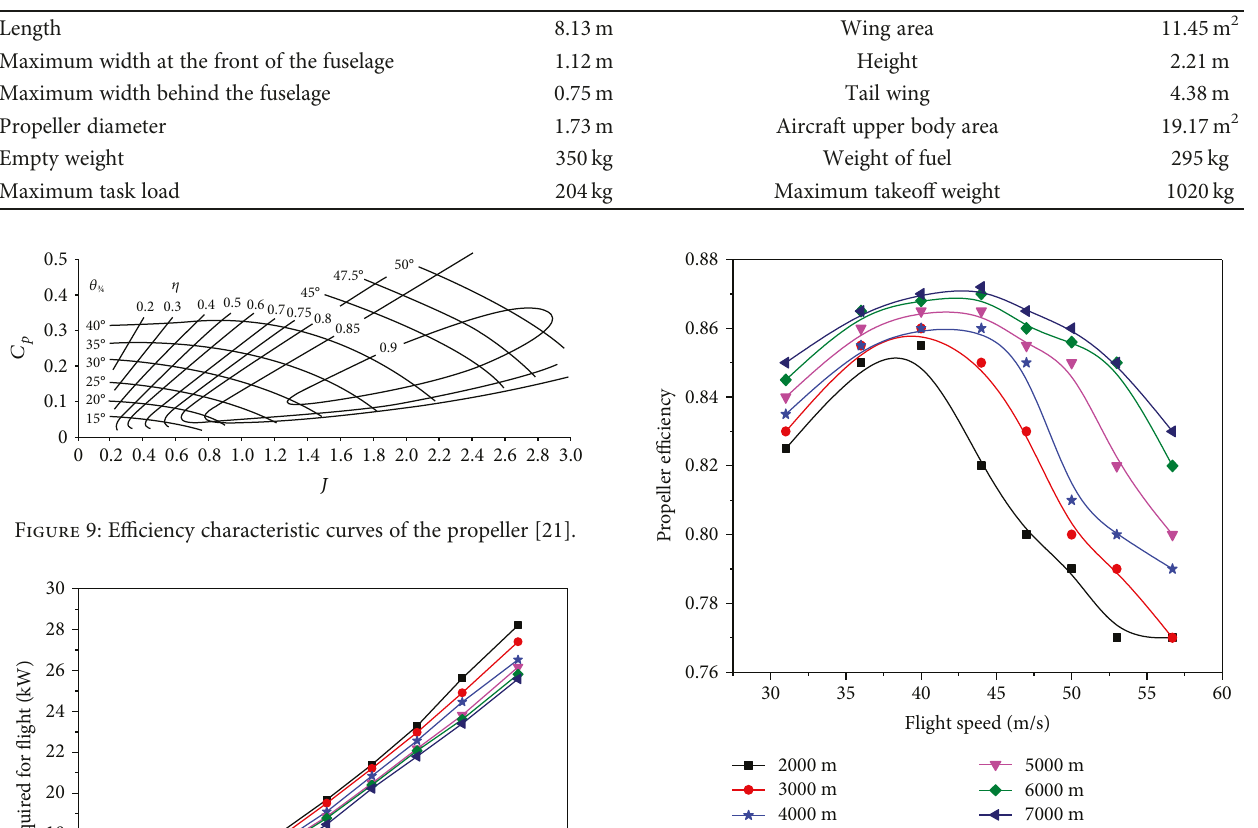
Figure 11: Curves of propeller e ffi ciency at di ff erent altitudes.